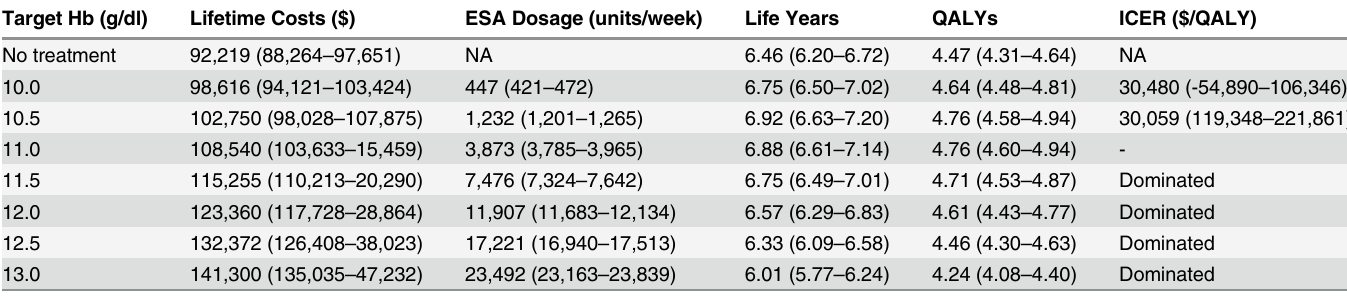
Table 5. Median (95% CI) lifetime cost, ESA dosage, life years, QALYs, and ICERs from probabilistic sensitivity analysis of incremental cost-effec- tiveness for different anemia treatment